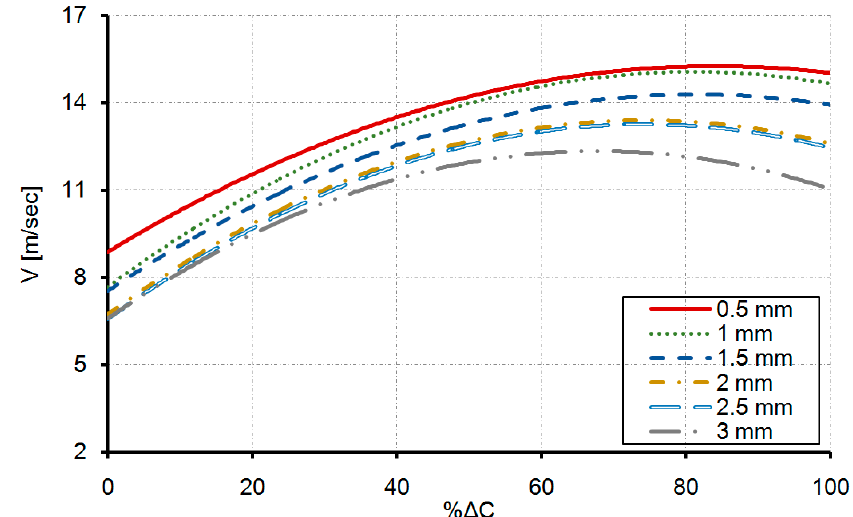
Figure 12. Velocity Profile over the gap from button to top at Trailing edge.